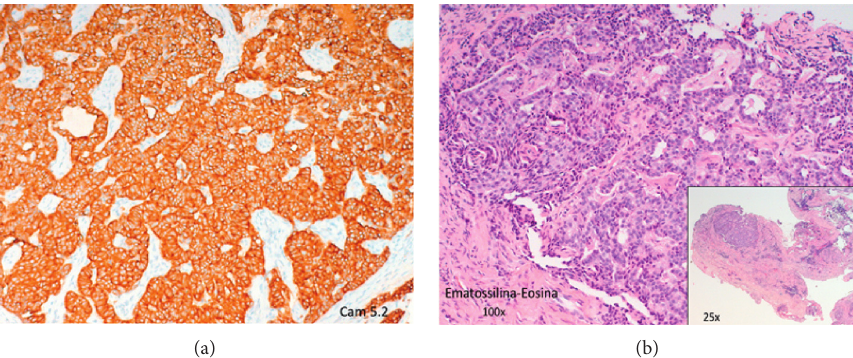
Figure 4: (a) Hematoxylin and eosin stain; the tumor was unencapsulated with an organoid growth pattern characterized by rounded nests and trabecular and glandular aggregates, with hyalinized fibrous stroma in the background (magnification × 25). Cytologically, the tumor cells lacked nuclear pleomorphism and exhibited finely dispersed nuclear chromatin (magnification × 100). (b) Immunohistochemistry results showed diffuse positivity for Cam